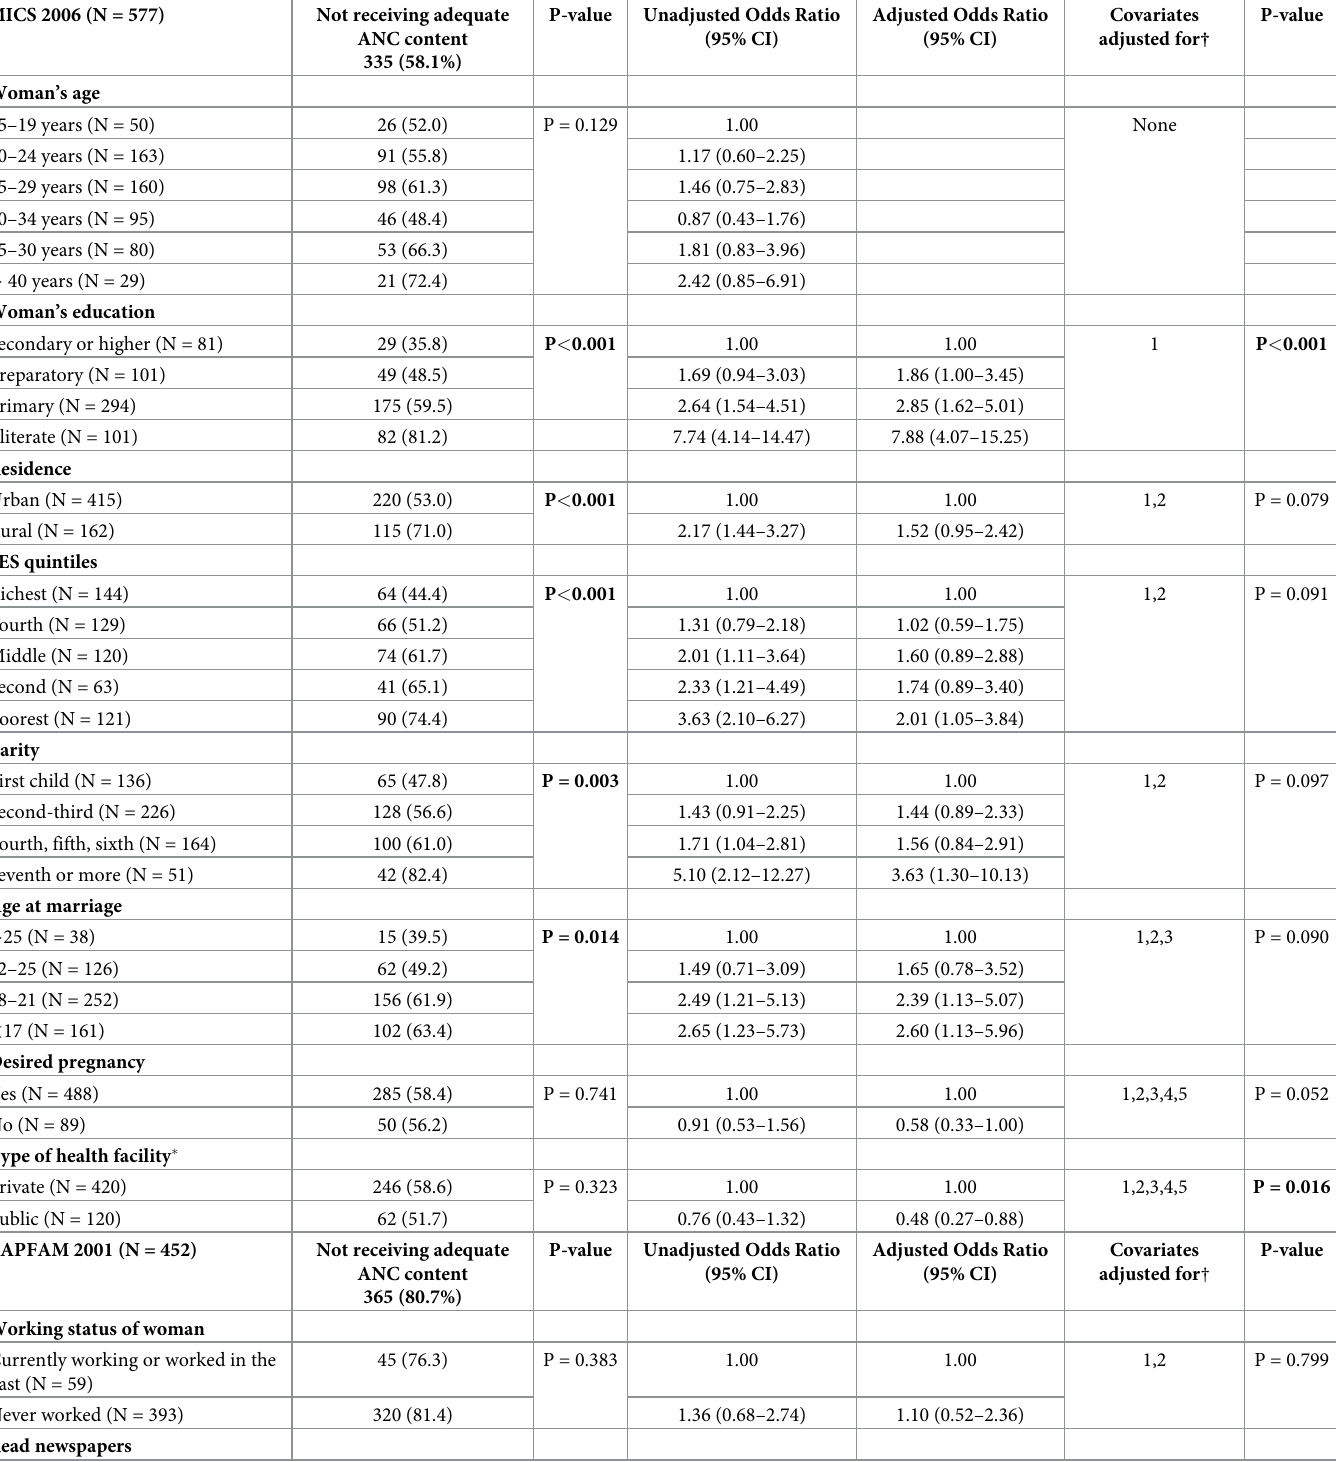
Table 2. Determinants of not receiving adequate ANC content in Aleppo, among women who attended ANC in MICS 2006, and PAPFAM 2001 (Phase